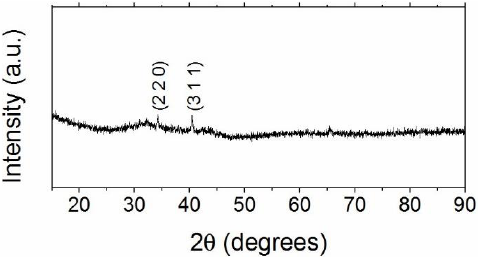
Figure 2. X-ray powder diffraction of SmFe 2 melt-spun ribbons.